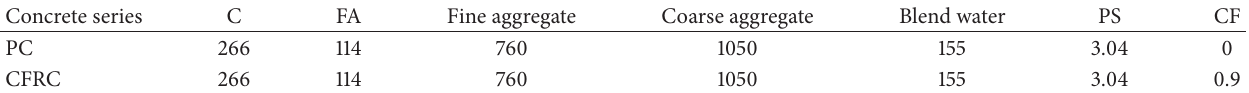
Table 3: Mix proportions of concrete (kg/m 3